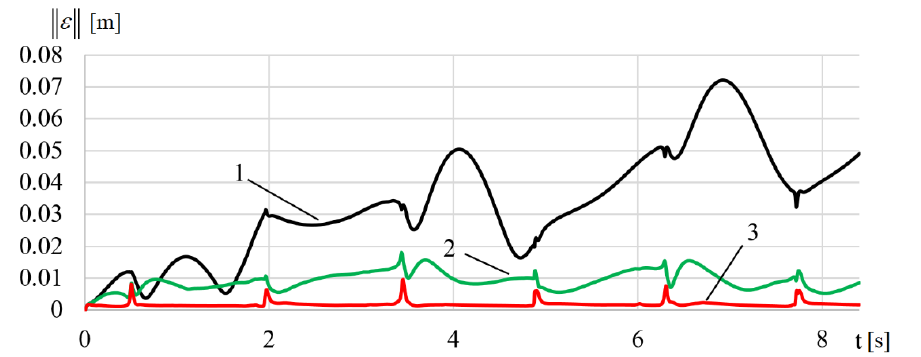
Figure 11. Magnitudes ‖𝑟⃗‖ of UUV’s linear displacements.